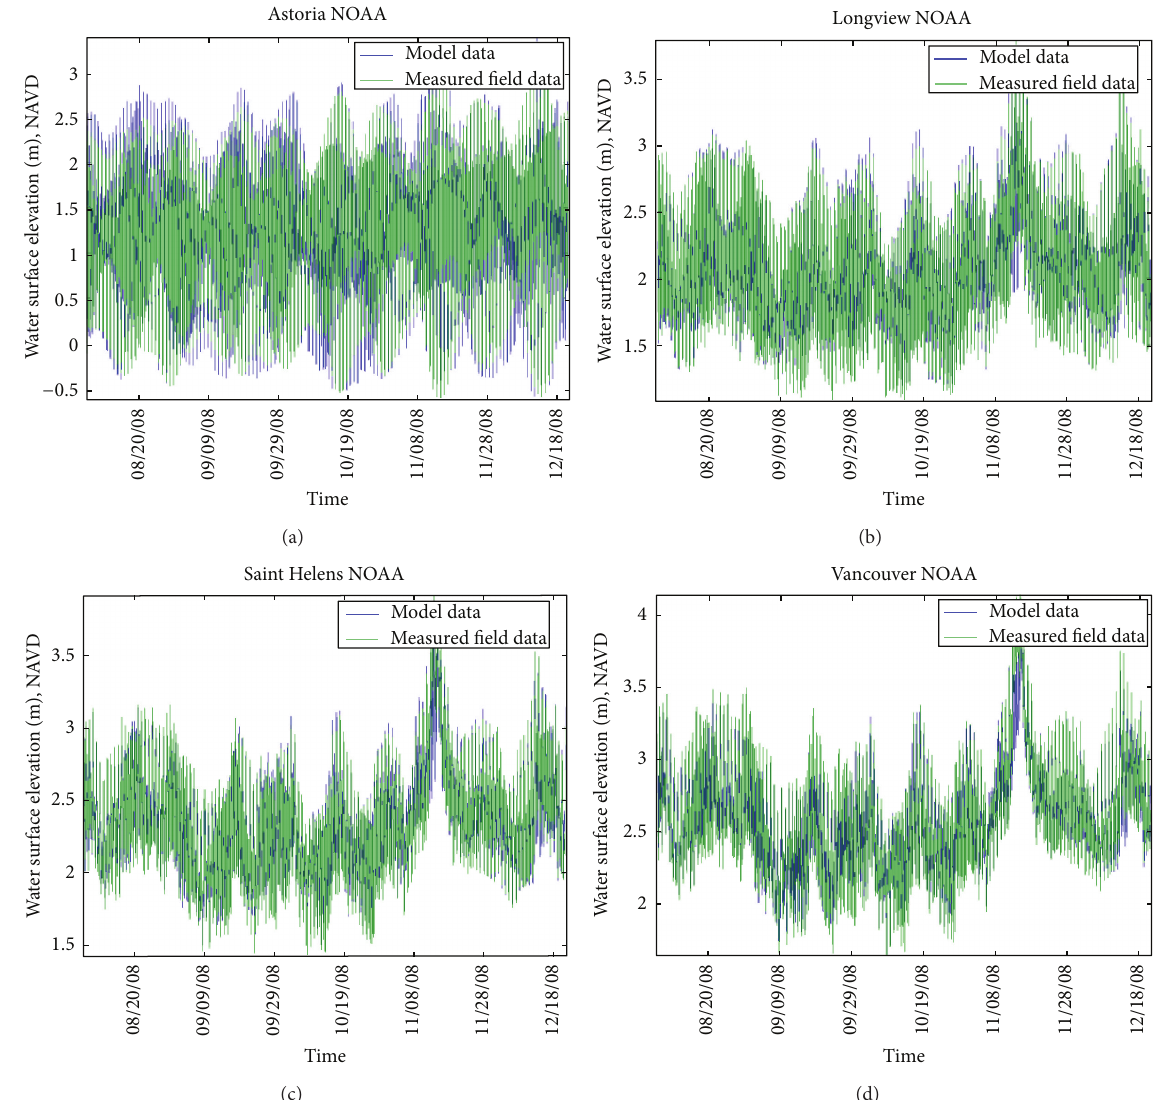
Figure 5: Water surface elevation at (a) Astoria, (b) Longview, (c) Saint Helens, and (d)